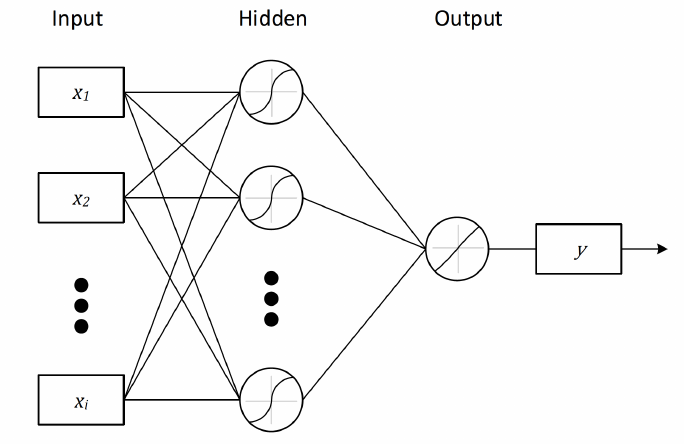
Figure 1. Multilayer perceptron’s model